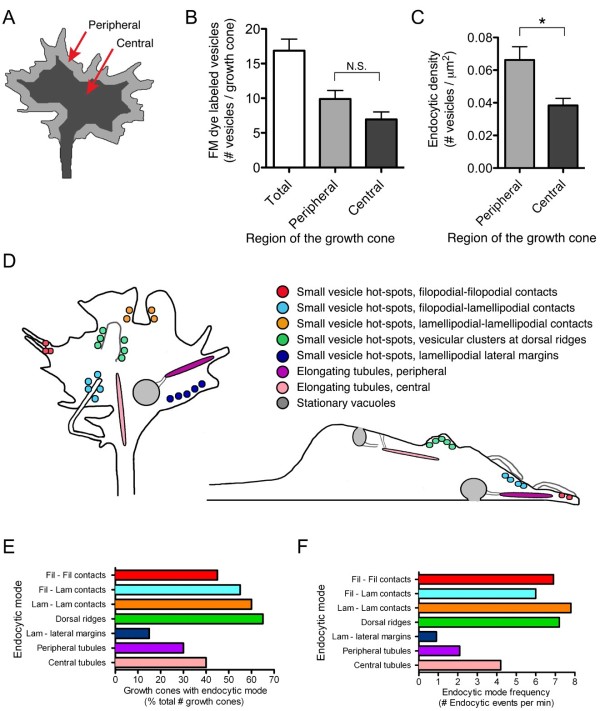
Distribution of endocytosis in the growth cone central and peripheral domains. (A) Schematic illustration of the growth cone peripheral and central regions (light and dark gray, respectively) used to determine the spatial distribution of endocytic vesicle formation (B-C). (B) Summary of the number of endocytic events in the indicated regions. Individual vesicles were counted 15 s after membrane labeling and classified based on their origin in peripheral or central regions as defined in (A). Colors (light and dark gray) correspond to (A). (C) Summary of the endocytic density in peripheral and central regions as defined in (A). Vesicles were counted as in (B) and the density reflects the number of endocytic vesicles per μm2. Data are the mean ± standard error of the mean obtained from 20 individual growth cones. N.S., P > 0.05, *P < 0.005, t-test. (D) Summary illustration of the endocytic modes described in Figures 2-10. A top-view (coronal section) of the growth cone is shown at the left. A side-view (sagittal section) is shown at the right where dorsal is up and ventral is down. The colors of labeled vesicles, tubules, and vacuoles correspond to the legend at the upper right. (E) Summary of the percentage of growth cones that displayed individual endocytic modes during the focal membrane labeling assays. The colors for each bar correspond to the legend and illustration in (A). (F) Summary of the frequency of individual endocytic modes observed during the FM dye assays. Spatial modes were counted in 20 individual growth cones and are displayed as the number of events per minute.